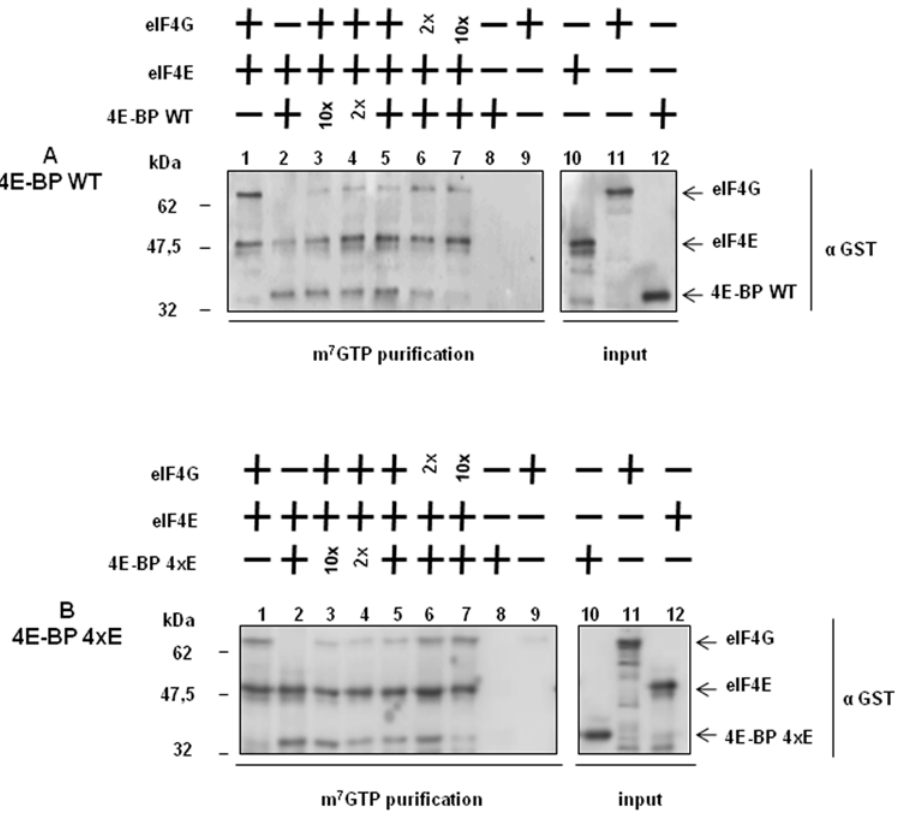
Figure 7. Wild type Sg4E-BP and the S/T-E variant inhibit eIF4E/eIF4G association with the same efficiency. Wild type (A) and the 4xE variant of Sg4E-BP (B) inhibit eIF4E/eIF4G association. The m 7 GTP sepharose beads was incubated (lanes 1–7) or not (lanes 8–9) with GST-mIF4E (eIF4E). Then, recombinant proteins GST-Sg4E-BP WT (WT, A) or GST-Sg4E-BP WT 4xE (4xE, B) and GST-SgIF4G (eIF4G) were added separately for lanes 1–2 and lanes 8–9, and together for other lanes (3-4-5-6-7). We used the same amount of GST-Sg4E-BP and GST-SgIF4G in lane 5, a 2-fold ratio in lanes 4 and 6 and a 10-fold ratio in lanes 3 and 7. Proteins were affinity-purified using m 7 GTP sepharose beads and were analysed by immunoblotting as described in Materials and Methods using an anti-GST antibody. Affinity-purified proteins were compared with the GST-fusion proteins loaded separately (lanes 10–12). Inputs represent 10% of the volume used in the experiment.